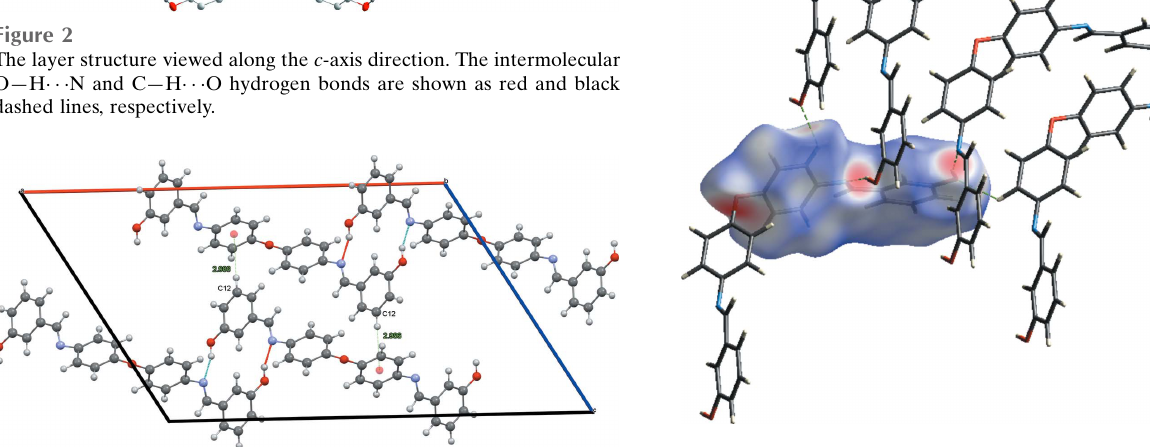
Figure 3 Side view of two layers seen along the b -axis direction. Hydrogen bonds and C—H (cid:2)(cid:2)(cid:2) (cid:2) interactions are depicted by dashed lines.